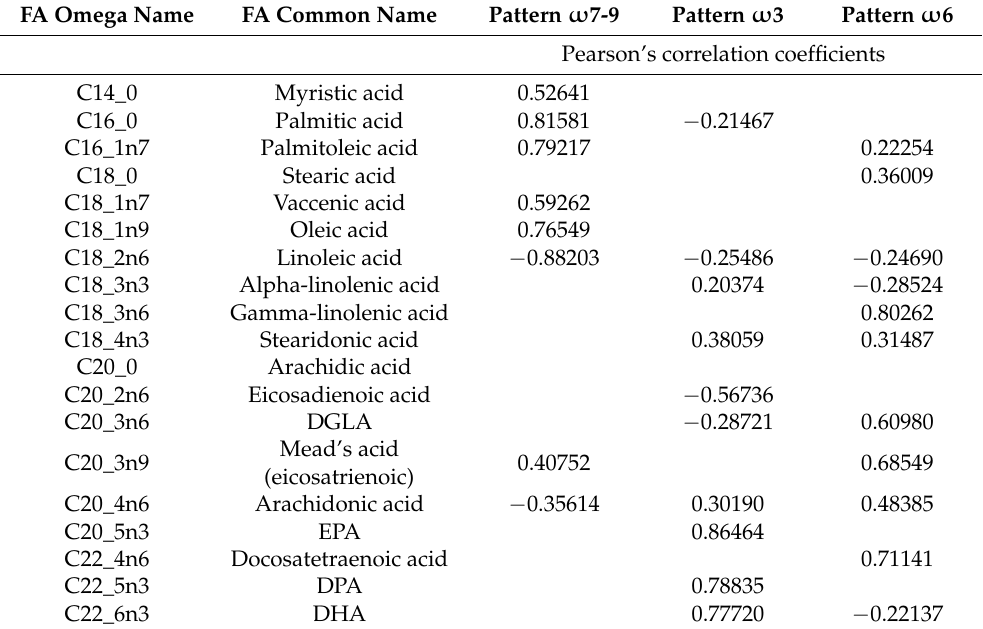
Table 2. Patterns of fatty acids (FAs) and contribution of each FA to the pattern (correlation coeffi- cients) ( n = 669).